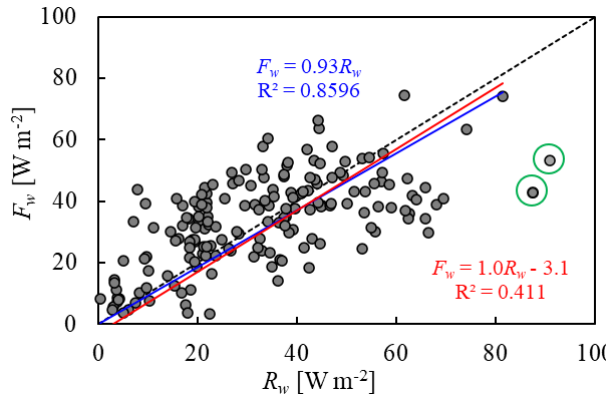
Figure 10. Linear fitting of daily water-to-ice heat flux F w as a function of penetrated solar radiation R w . The dashed black line denotes F w = R w . Two models were used to fit the data with two dots in green circles being